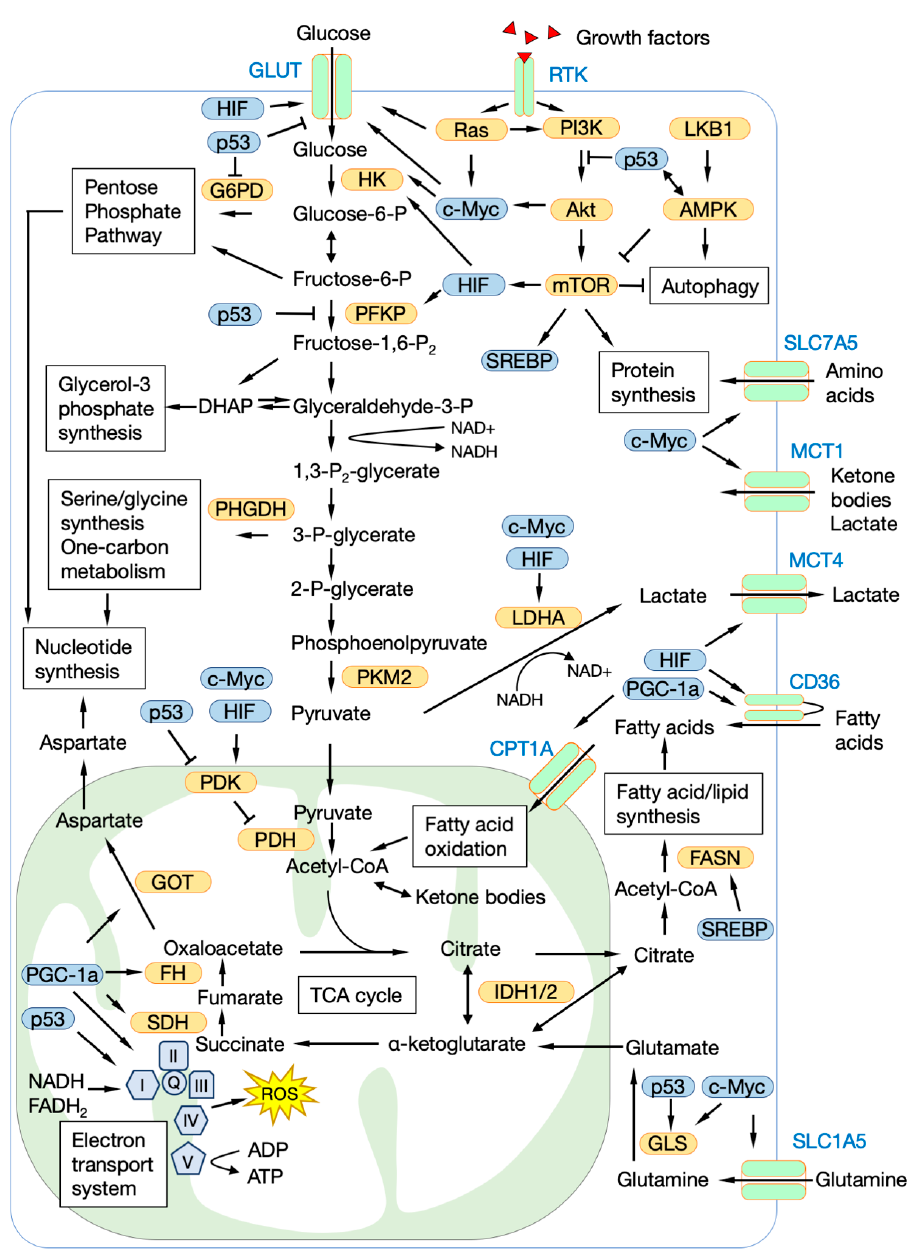
Figure 1. The central carbon metabolism map in cancer cells. GLUT, glucose transporter; RTK, receptor tyrosine kinase; MCT, monocarboxylate transporter; SLC7A5, solute carrier family 7 member 5; SLC1A5, solute carrier family 1 member 5; HK, hexokinase; G6PD, glucose-6-phosphate dehydrogenase; PFKP, phosphofructokinase platelet; PHGDH, phosphoglycerate dehydrogenase; PKM2, pyruvate kinase M2; LDHA, lactate dehydrogenase A; PI3K, phosphatidylinositol-3 kinase; LKB1, Liver kinase B1; AMPK, AMP-activated protein kinase; mTOR, mammalian target of rapamycin; FASN, fatty acid synthase; GLS, glutaminase; PDK1, pyruvate dehydrogenase kinase 1; PDH, pyruvate dehydrogenase; IDH, isocitrate dehydrogenase; SDH, succinate dehydrogenase; FH, fumarate hydratase; GOT, glutamic-oxaloacetic transaminase; I-X, electron transport chain complex I-X; PGC-1a, peroxisome proliferator-activated receptor gamma coactivator 1-alpha; HIF, hypoxia inducible factor; SREBP, sterol regulatory element binding transcription factor .